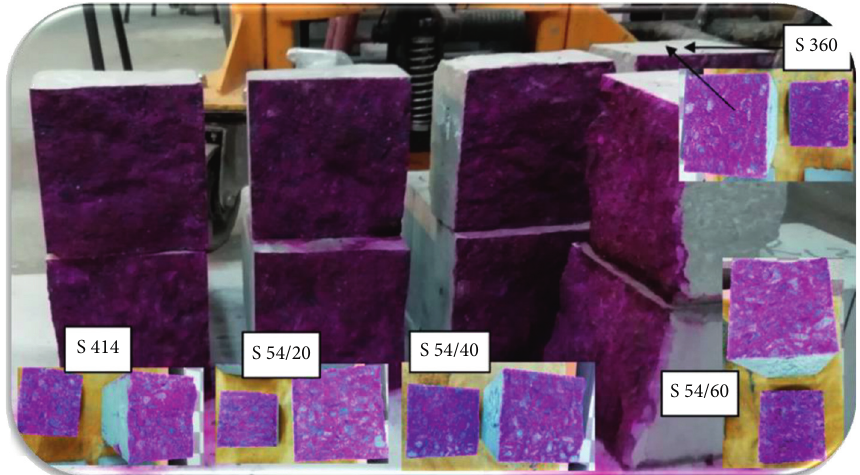
Figure 11: Carbonatation progress after 1 hour since the testing of the samples at the age of 56 days.